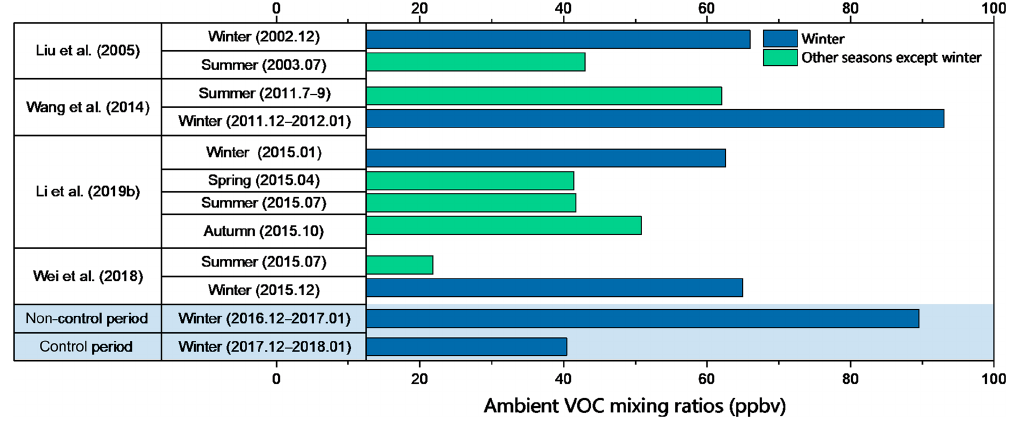
Figure 3. Ambient VOC mixing ratios (ppbv) in different seasons of